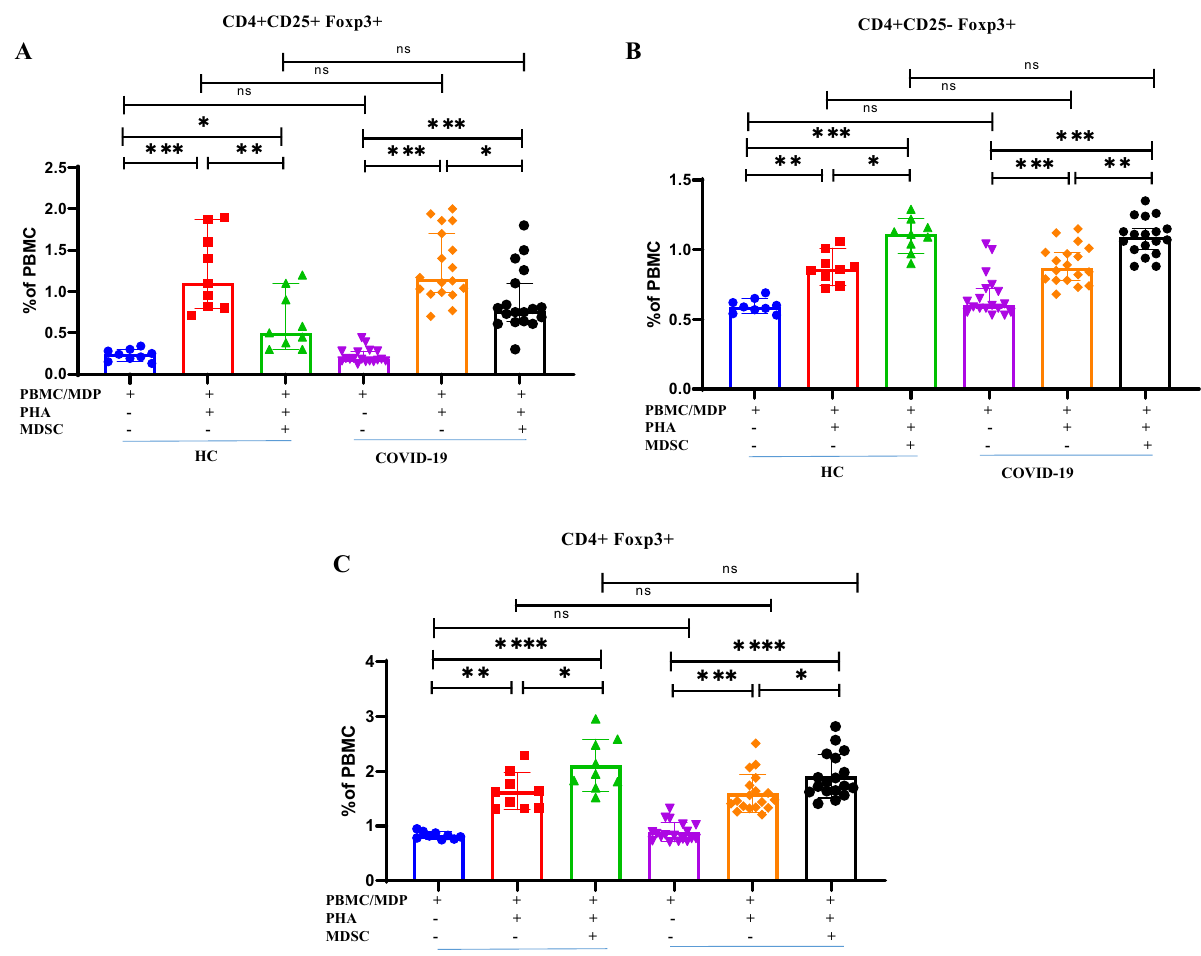
Figure 5. Isolated MDSCs induced CD4 + CD25- Foxp3 + T cells. Isolated MDSCs from fresh PBMC of patients co-cultured with autologous MDPs from the same patients and homologous PBMCs from HCs in the presence of PHA for 3 days. Dot plots show the percentage of CD4 + CD25 + Foxp3 + ( A ), CD4 + CD25 - Foxp3 + ( B ) and CD4 + Foxp3 + cells ( C ) from 18 COVID-19 patients and 9 HCs All values are presented as the median and 5–95% percentile and comparisons made between control and patient groups were performed using kruskalwalis followed a Dunn’s test. *P < 0.01, **P < 0.001, ***P < 0.0001 and ****P < 0.0001. HC healthy control, P : patients, MDP MDSC depleted